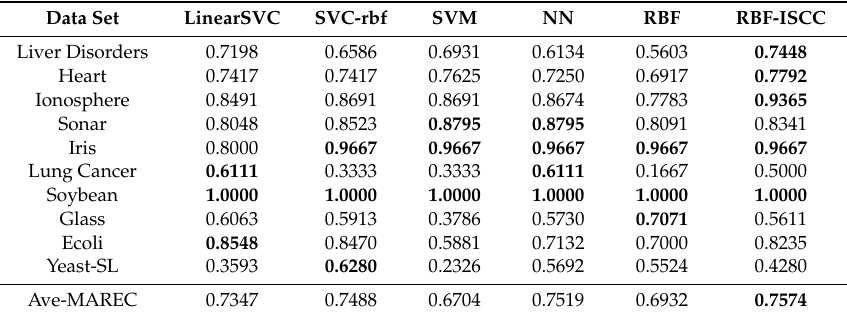
Table 4. Testing macro-averaged recall (MAREC) obtained for single-label data